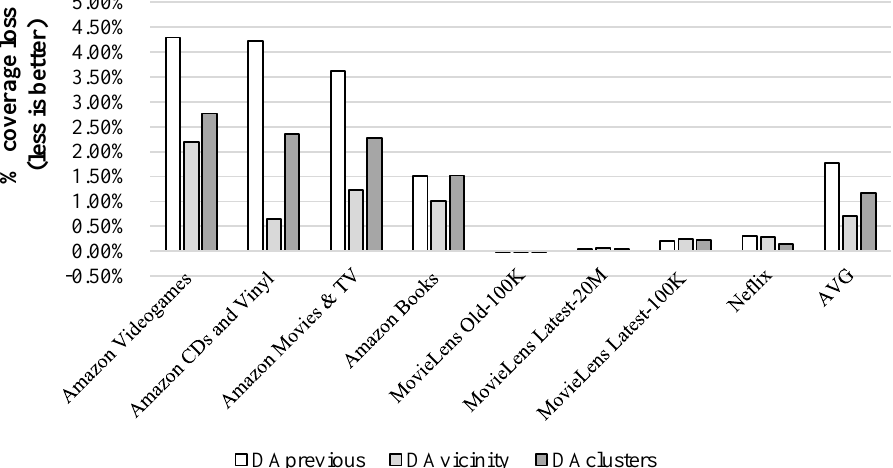
Figure 4. Predictions (cases) lost when applying the DA